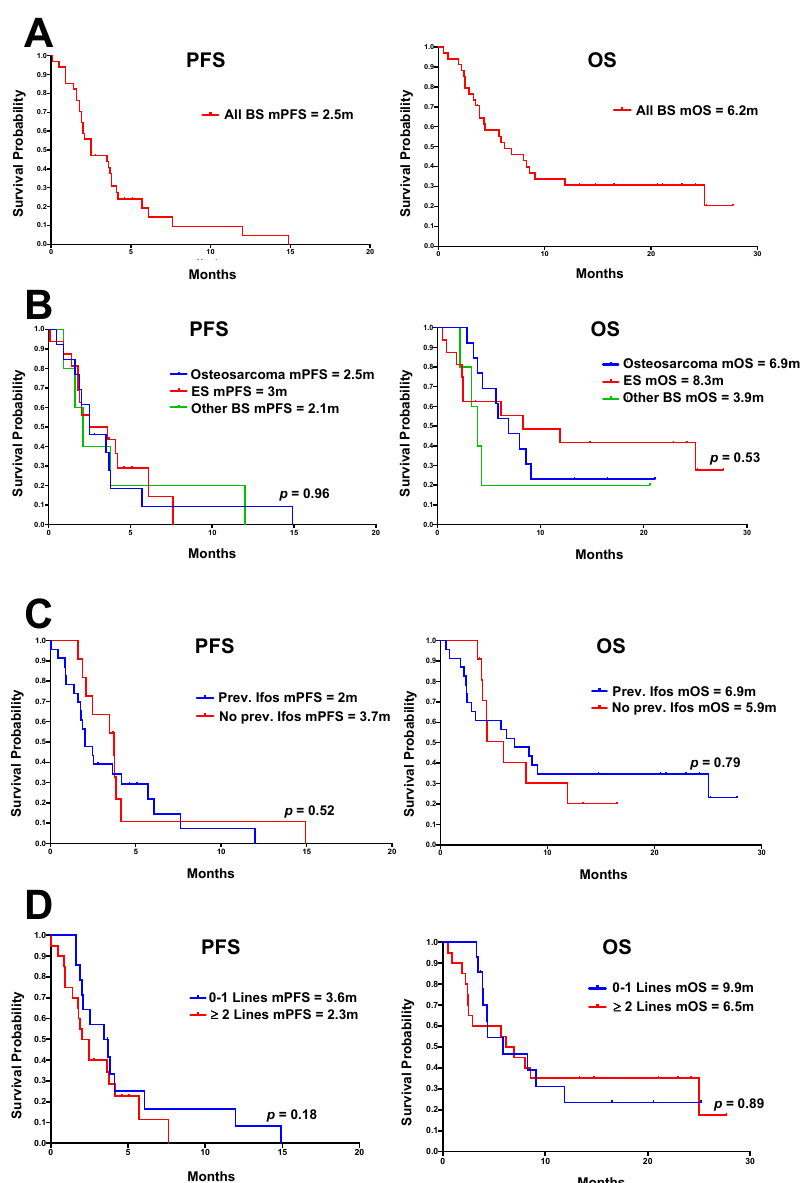
showing PFS, timing of treatment cessation and current status for individual patients is shown in Figure 5.